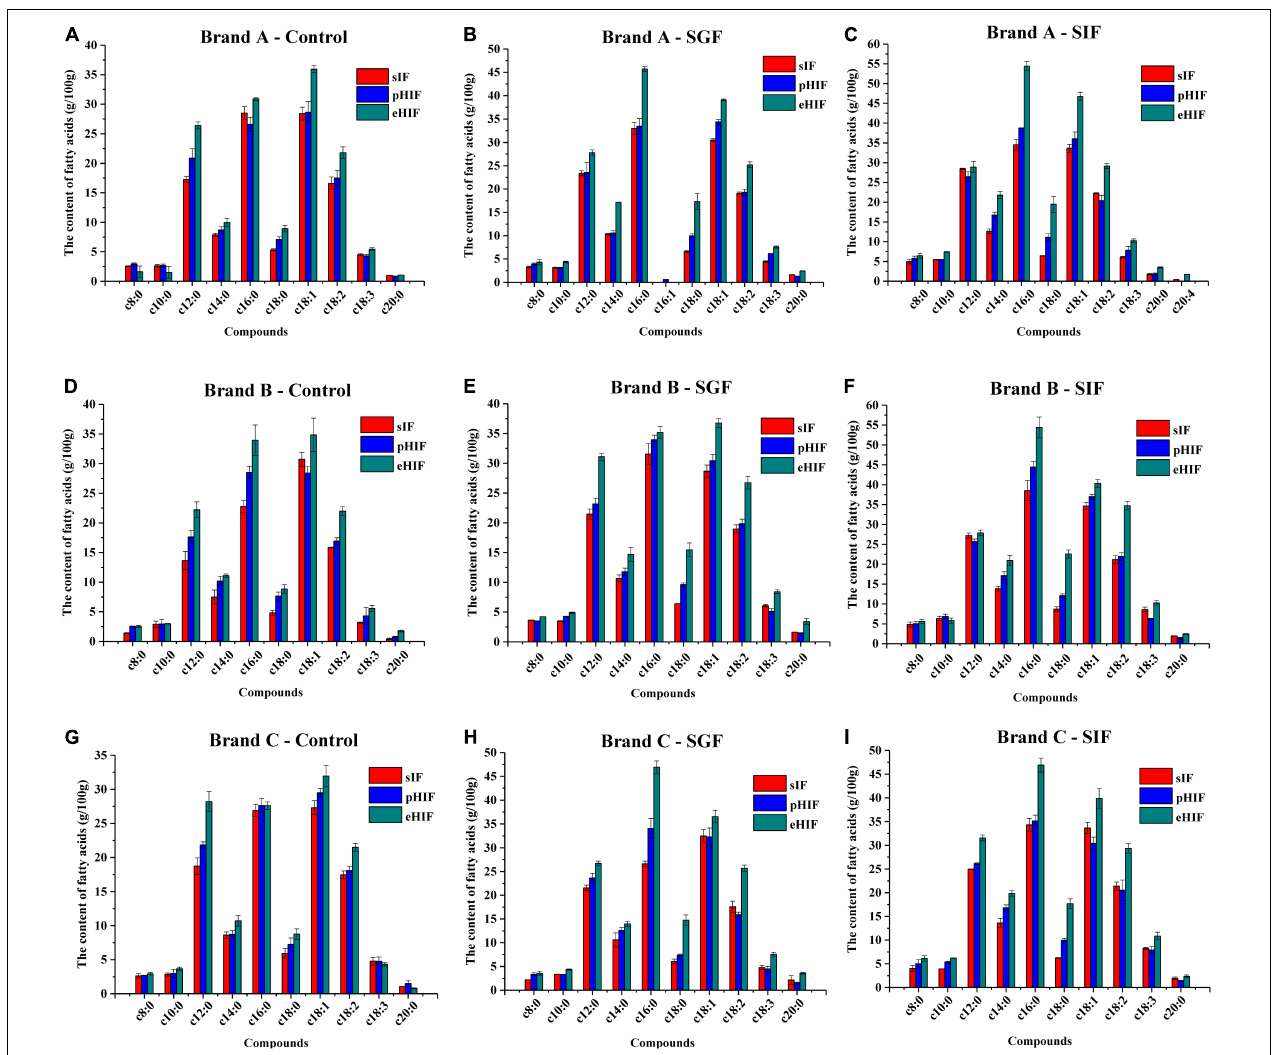
FIGURE 3 | Characteristics of fatty acids in infant formulas during in vitro digestion, n = 3 independent experiments. (A–C) Represent the brand A infant formulas during control, SGF, and SIF digestion stages, respectively. (D–F) Represent the brand B infant formulas during control, SGF, and SIF digestion stages, respectively. (G–I) Represent the brand C infant formulas during control, SGF, and SIF digestion stages,